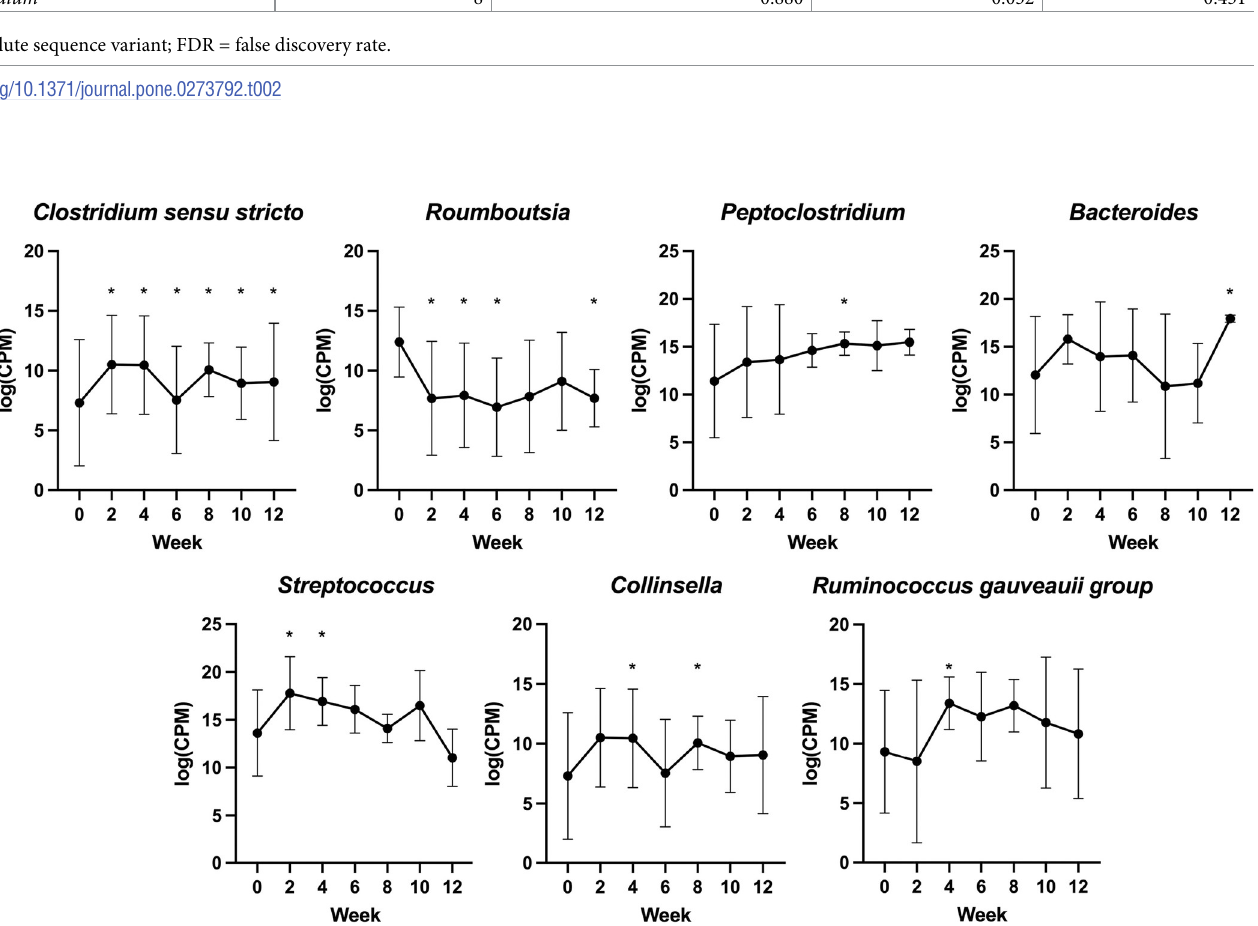
ASV = absolute sequence variant; FDR = false discovery rate.